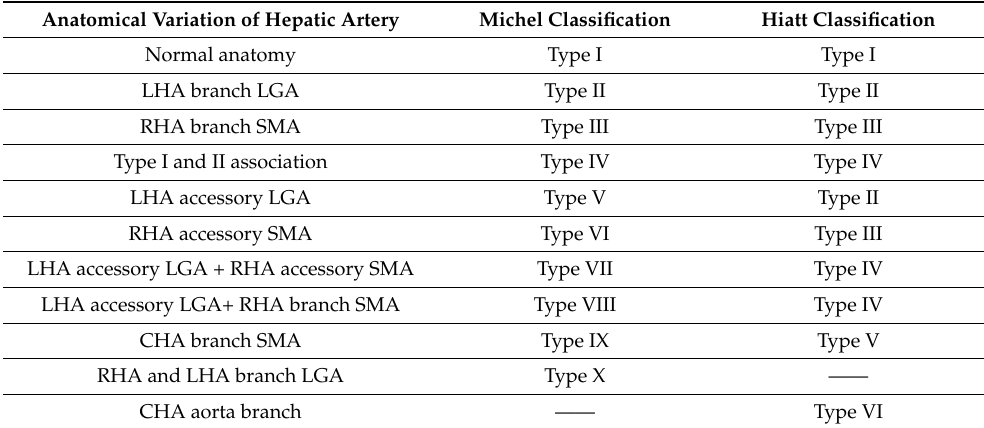
Table 1. Showing the anatomical variations of the hepatic artery based on the classification of Michel and